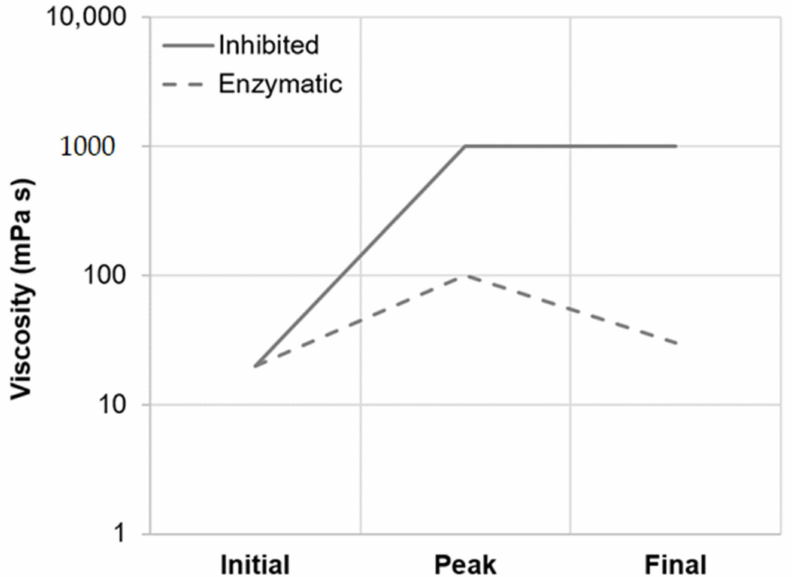
Figure 7. Principal viscosity progression of barley malt samples isothermally mashed at inhibited versus enzymatic conditions for 5 min. The curves are representative of all temperature levels investigated (i.e., GT O , PT O and PT 5